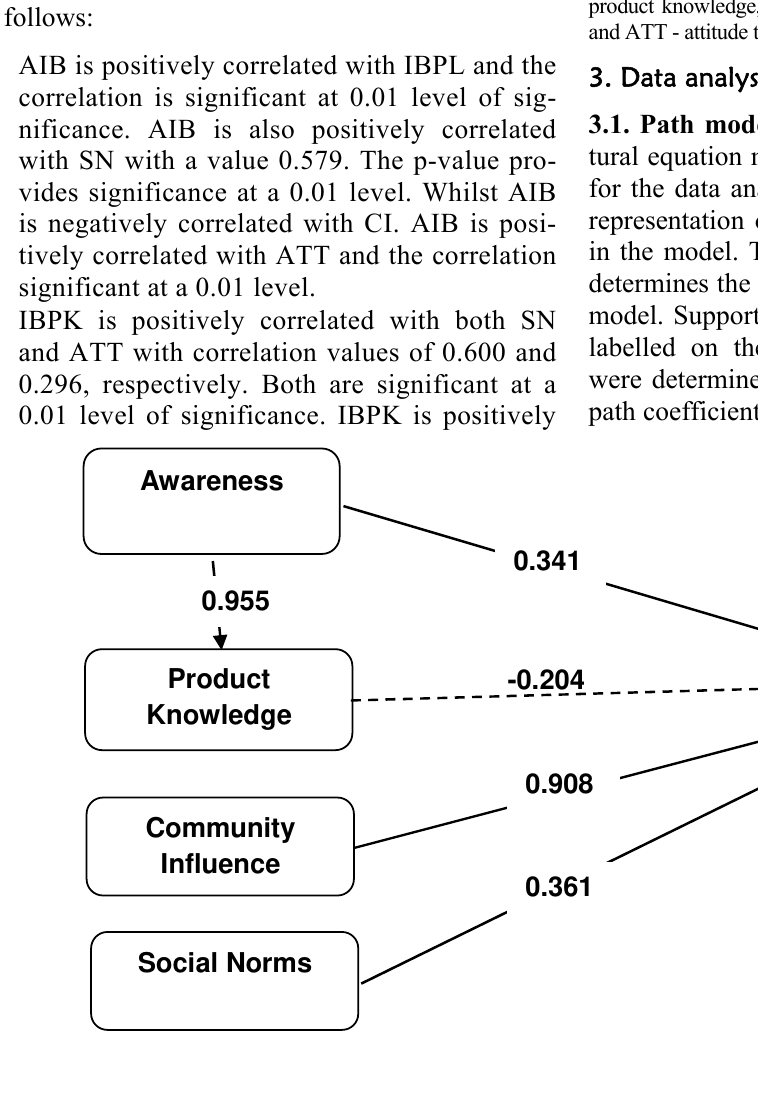
Fig. 2. Measurement and structural model